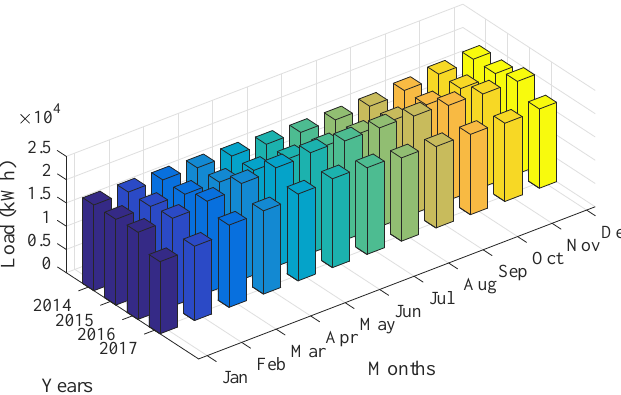
Figure 6. FE power grid electrical energy consumption on monthly basis for the years 2014–2017.